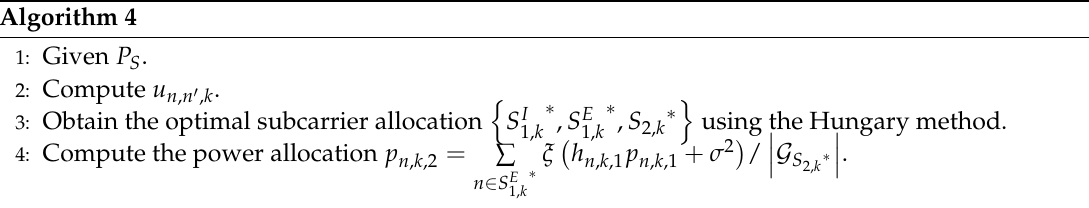
Algorithm 4: The power allocation for a relay to forward the S signal in the second timeslot is equally allocated. The number of subcarriers for each relay used to decode information in the first timeslot is consistent with the number of subcarriers utilized for forwarding re-encoded information in the second timeslot. The Hungary method is used to perform the subcarrier allocation according to + SNR h n , k ,1 p n , k ,1 n (cid:48) , k ,2 = SNR n , k ,1 u n , where SNR n , k ,1 = , n (cid:48) , k SNR n , k ,1 · SNR n (cid:48) , k ,2 σ